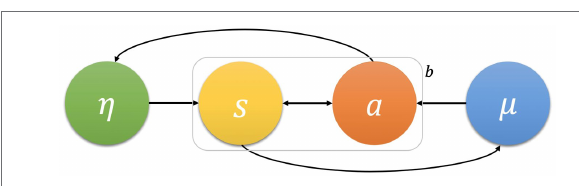
FIGURE 1 | A Markov blanket delineates the conditionally independent internal ( μ ) and external states ( η ) (the arrows represent conditional dependencies between random variables). Considering that there is no arrow between μ and η , these states are conditionally independent, being indirectly influenced by blanket states ( b ) comprising active ( a ) and sensory ( s ) states. Given its scale-free, this formalism can be applied to explain the influential flows and dynamics of any open system at any